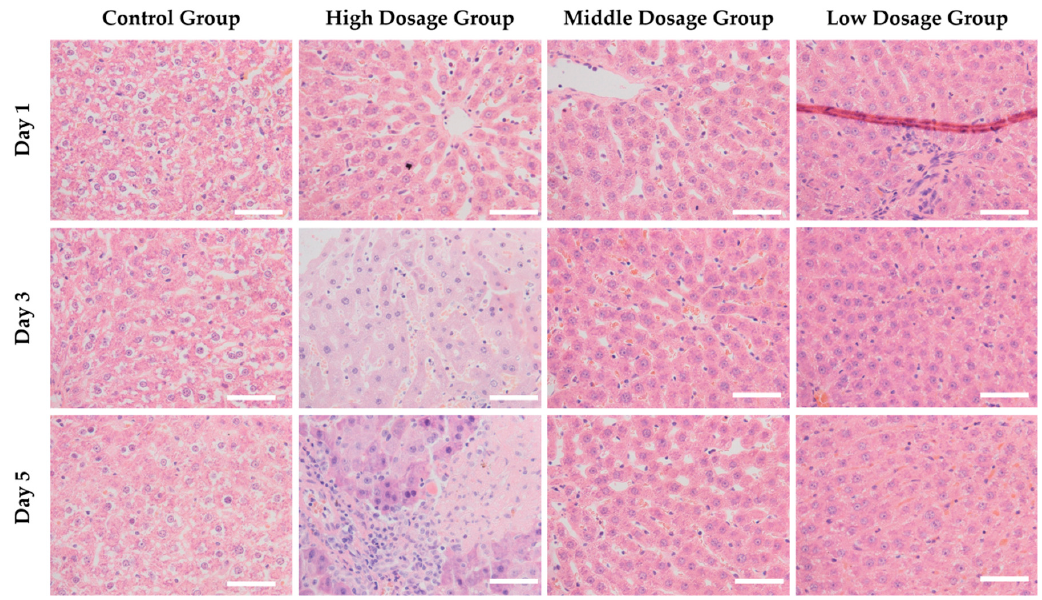
Figure 5. Hematoxylin ‐ eosin (HE) staining of Sprague ‐ Dawley (SD) rat livers at various indicated days after injecting hydrogels with different drug dosages into the vagina (high dosage, middle dosage, and low dosage). The CP ‐ 3 block copolymer solution at the concentration of 30 wt% was used. The volume of drug ‐ loaded copolymer solution injected into the vagina is 0.2 mL. Copolymer solutions without loading drug were injected into the vagina of SD rats as a control group, scale bar: 5 μ m.